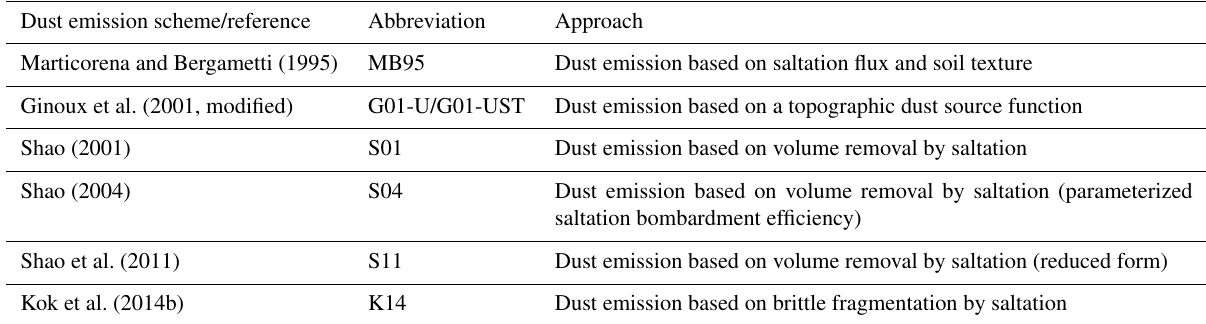
Table 2. Summary of the six available dust emission schemes in MONARCH. Dust emission